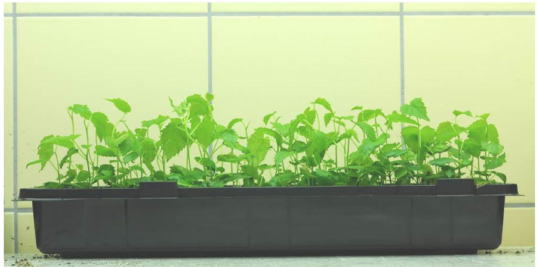
Figure 7. Fully acclimated plantlets of mountain mulberry ‘Kenmochi’ obtained by rooting microshoots in vivo four weeks